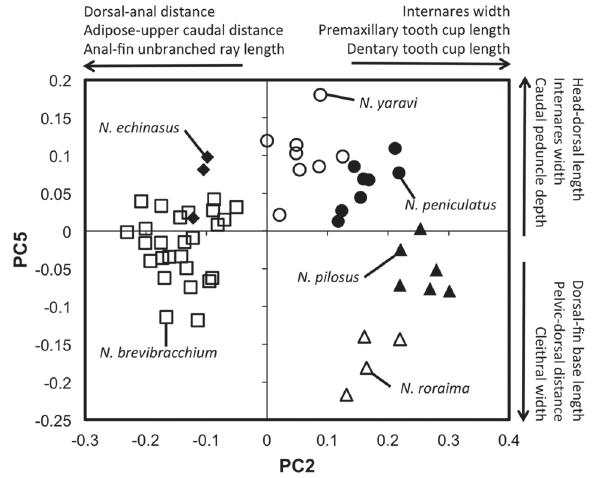
Fig. 5. Principle Components Analysis of species of Neblinichthys . Most strongly loading measurements and their directions indicated. PC2 represents 6.3% of the total variation and PC5, 1.6% (note, most variation, 81.7% is in PC1, which represents overall size). Barbel length was excluded because of extreme variance and interorbital width was excluded because it was not measured the same throughout the